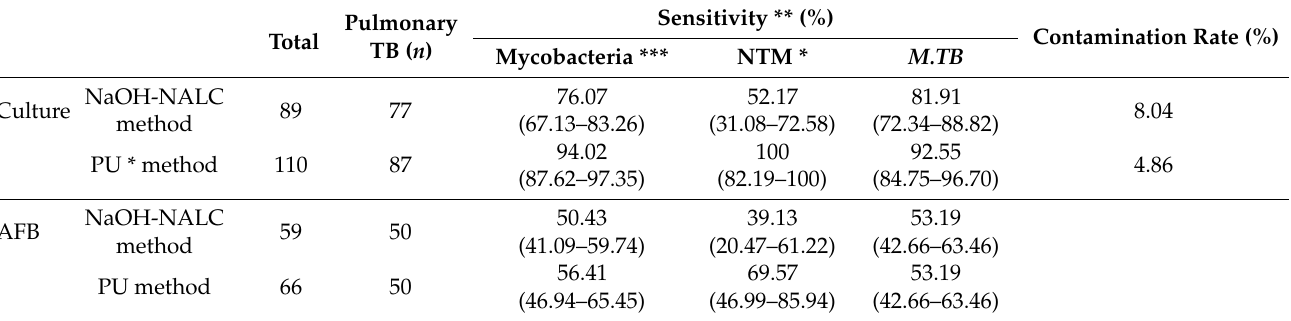
Table 2. Evaluation of AFB smear and culture results of suspected pulmonary TB patients using NaOH-NALC and PU methods of